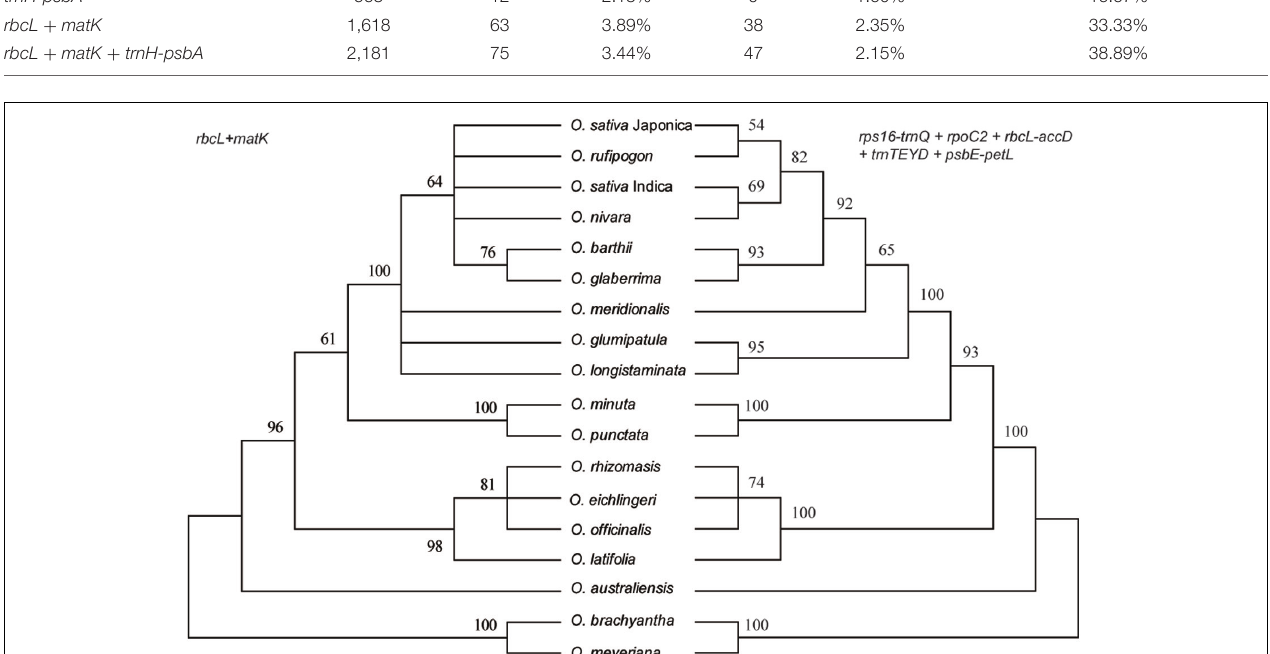
half of the samples were successfully identified within